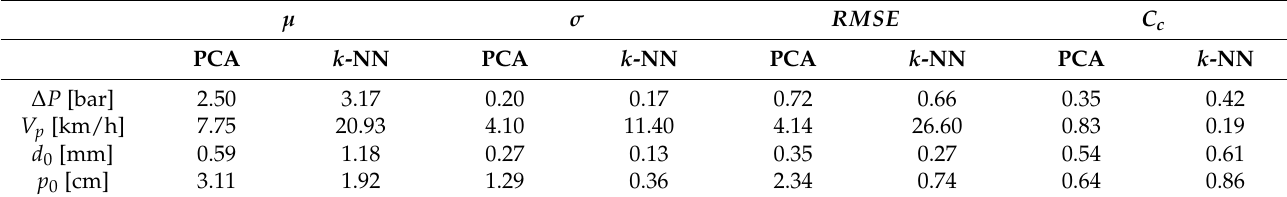
Table 10. Statistics of the OPP soft-sensor predictor with PC regression compared to k -NN